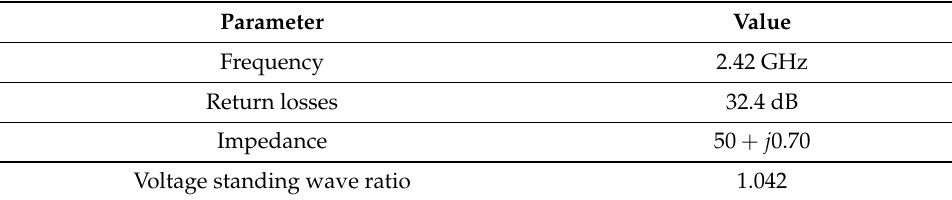
Table 2. Transmission parameters in antennas.